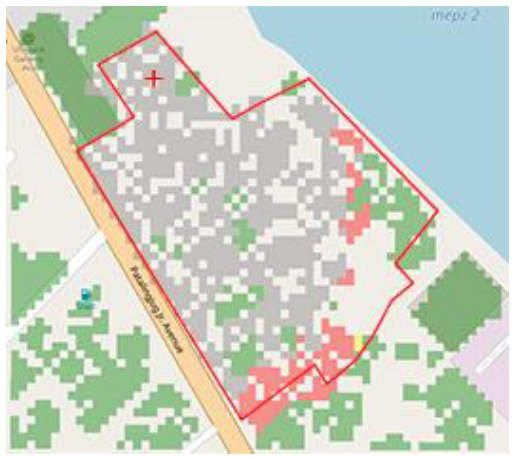
Figure 11: Completed fire spread simulation (actual extent outlined in red, fire origin marked by ‘+’) Based on the collected data from the FireCheck Project, the fire lasted around 77 minutes with the wind blowing at 2m/s towards the SW (bearing of 120°). With an 𝛼 of 1, Figure 11 shows the simulated fire spread over the same area. The model achieved an 83.54% accuracy score with a Cohen’s kappa of 0.67. Visually, the simulated fire spread misses a few cells on the edge of the extent which contributes to the decrease of